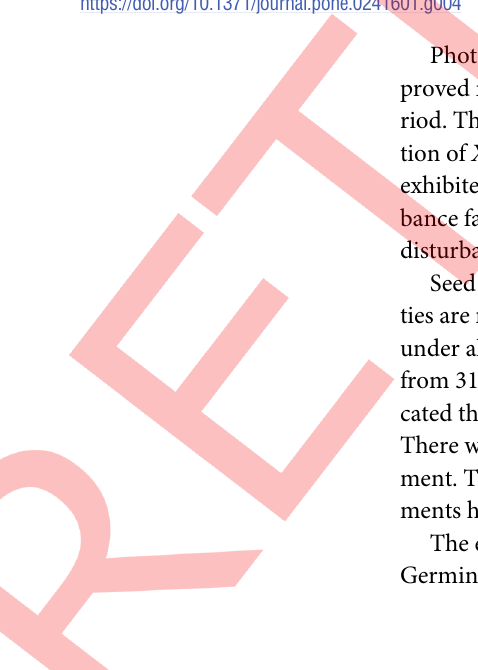
Fig 4. The influence of different NaCl salinity levels on seed germination percentage of ruderal and agricultural populations of Xanthium strumarium L.